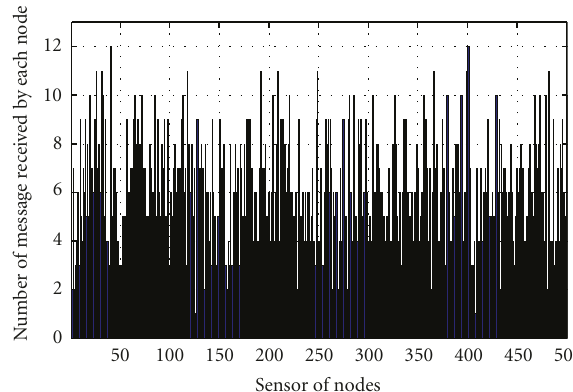
Figure 4: Average number of messages for each node in a network of 500 sensor nodes.